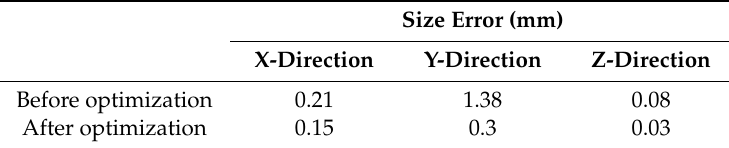
Table 3. The size error of the model before and after optimization.